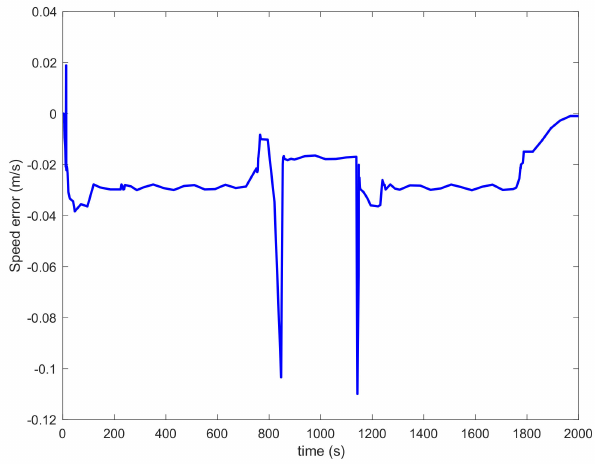
Figure 12. Speed error of ATSM-FTC.